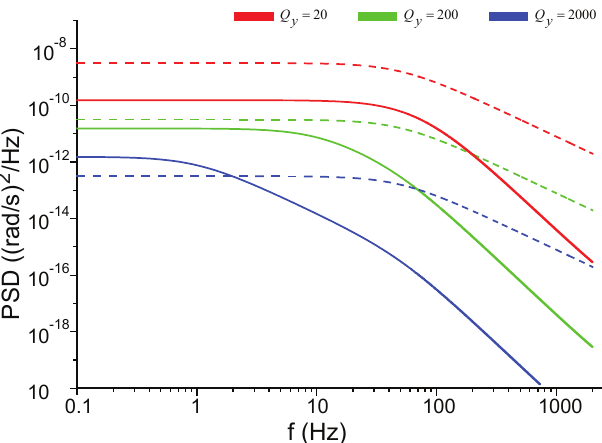
Figure 7. The PSD of the NER for different Q y in open-loop mode-matched gyroscopes. Solid lines for the mechanical noise. Dashed lines for the electrical noise.